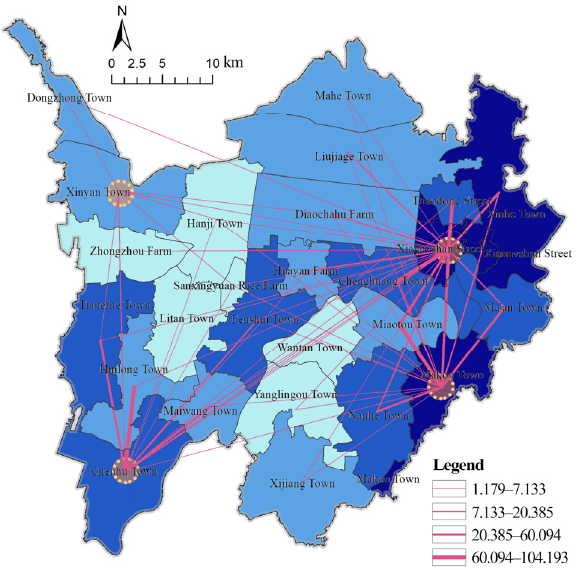
Figure 6. Spatial distribution of urban–rural integration development centers.